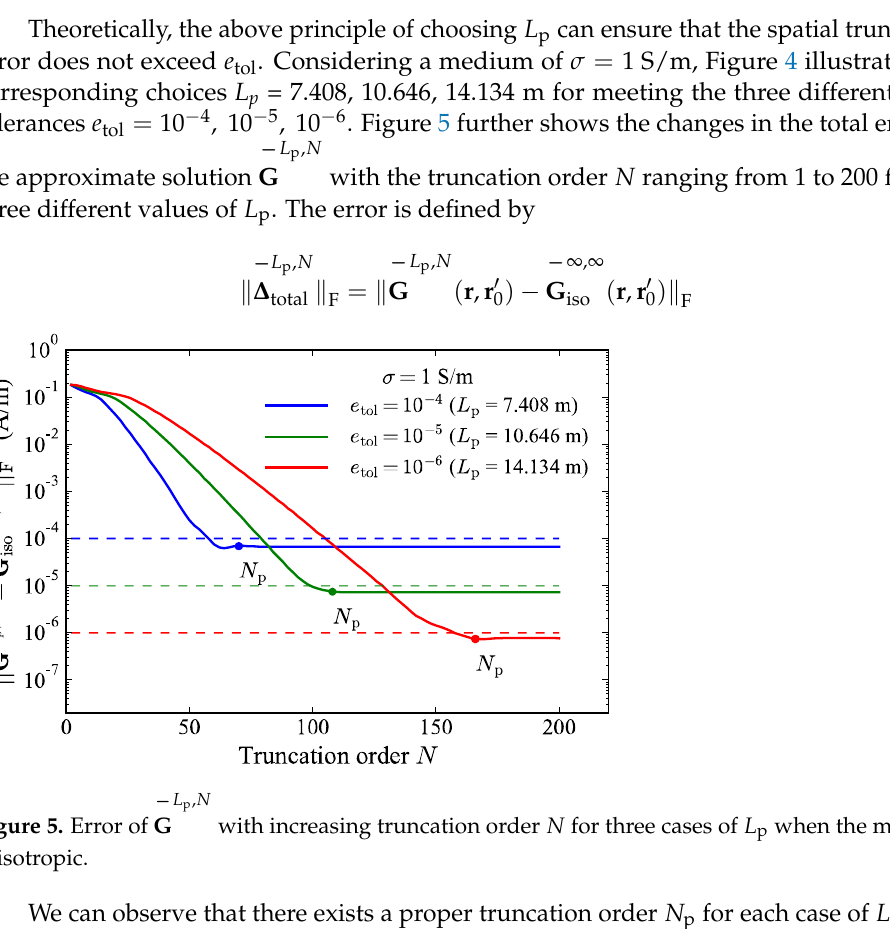
( , ) f L  and the illustration of the process for choosing proper 3